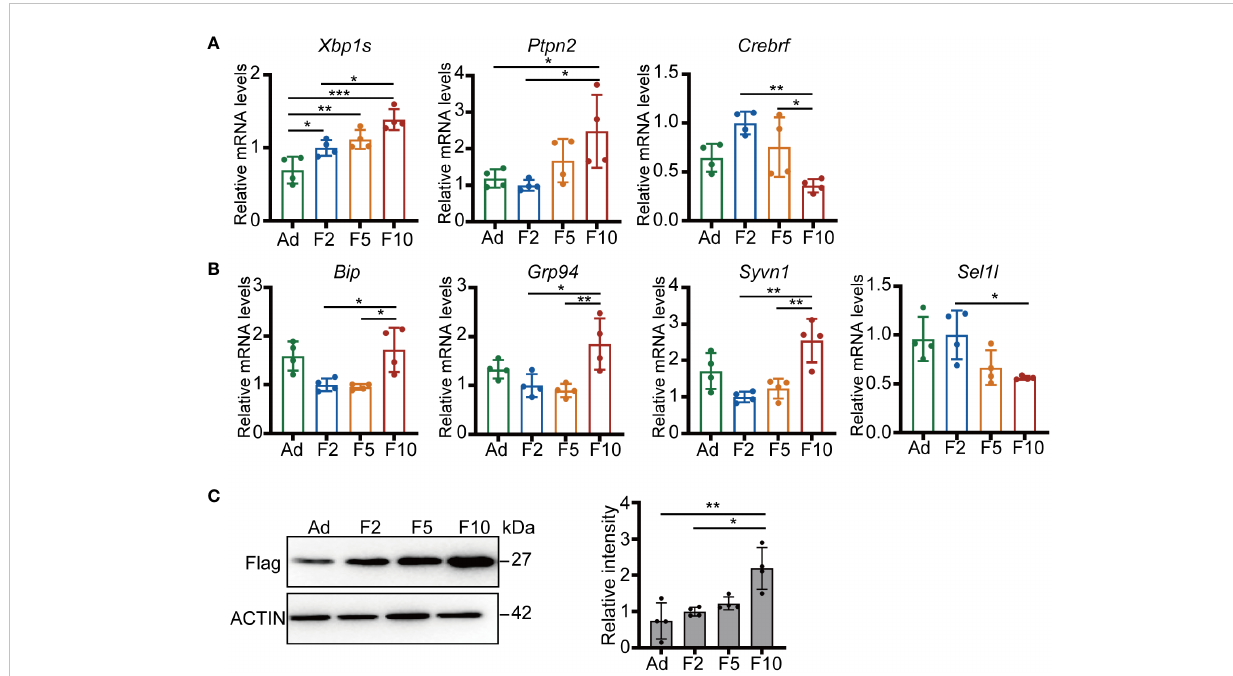
FIGURE 4 Multigenerational DRF exacerbates ER stress. (A) Relative mRNA levels of Xbp1s , Ptpn2 and Crebrf (n = 4). (B) Relative mRNA levels of Bip , Grp94 , Syvn1 , and Sel1l (n = 4). (C) Protein levels of fl ag-tagged folding-de fi cient mutant proinsulin 20 h after injection (one representative fi gure is shown) and quanti fi cation of FLAG/ACTIN protein levels (n = 4). All signi fi cance was calculated by one-way ANOVA. * P < 0.05; ** P < 0.01; *** P < 0.001 were considered signi fi cant. Error bars represent the mean ±